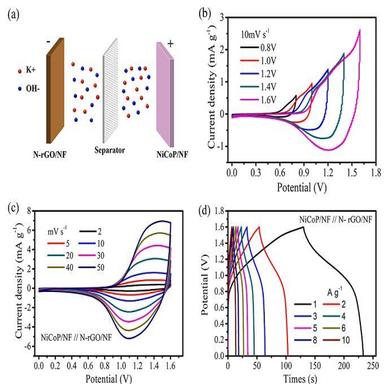
(a) Schematic illustration of hybrid supercapacitor NiCoP/NF//NrGO/NF, (b) CV curves at different work voltages, (c) CV curves in the operating potential window between 0-1.6 V, (d) GCD curves.